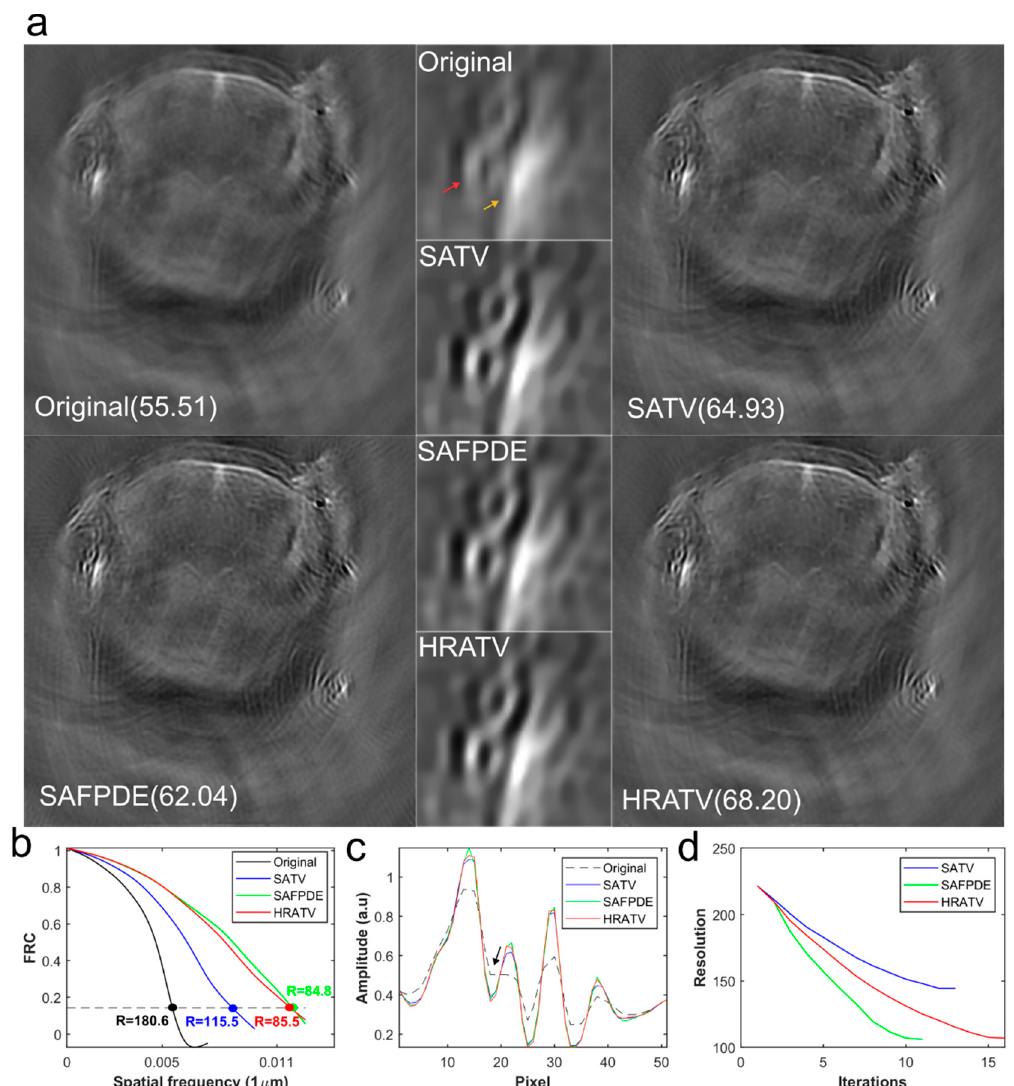
Figure 8. Deconvolution results of mouse brain. ( a ) Original image and images after deconvolutions. The vessel indicated by the red arrow is selected to calculate the SNR and the results are shown beside the image titles. ( b ) FRC measurements of the original image and the images after deconvolutions. ( c ) Line profiles of the vessels indicated by the yellow arrow. ( d ) Estimated resolution during